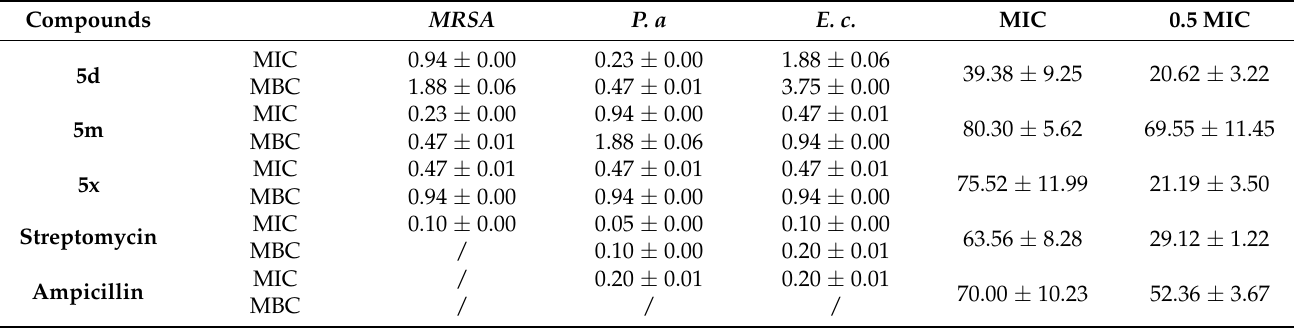
Table 3. Antibacterial activity against resistant strains (MIC/MBC in mg/mL) and inhibition of biofilm formation (%). Compounds MRSA